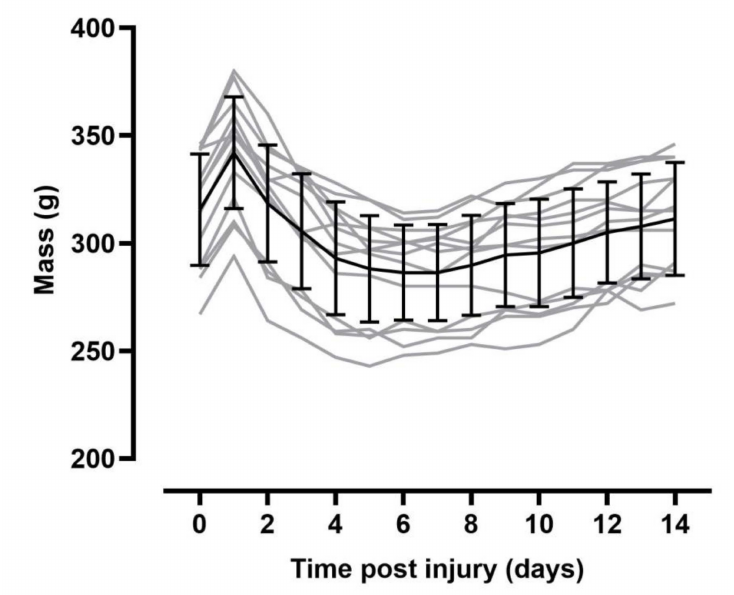
Figure 2. Body mass with time pre/post-injury. Note there were no significant differences in body mass across the 14-day study period. Black lines indicate mean mass ± SD, grey lines represent individual animals body mass.